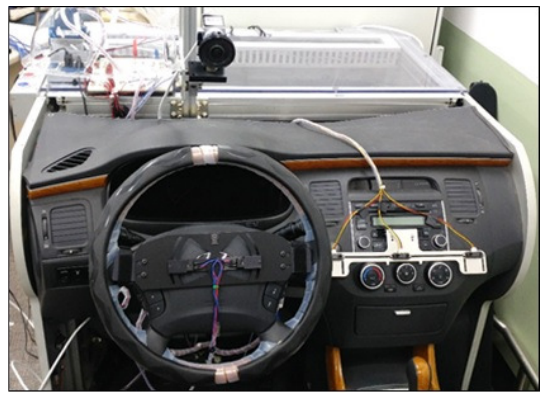
Figure 2. Experimental design on driver monitoring